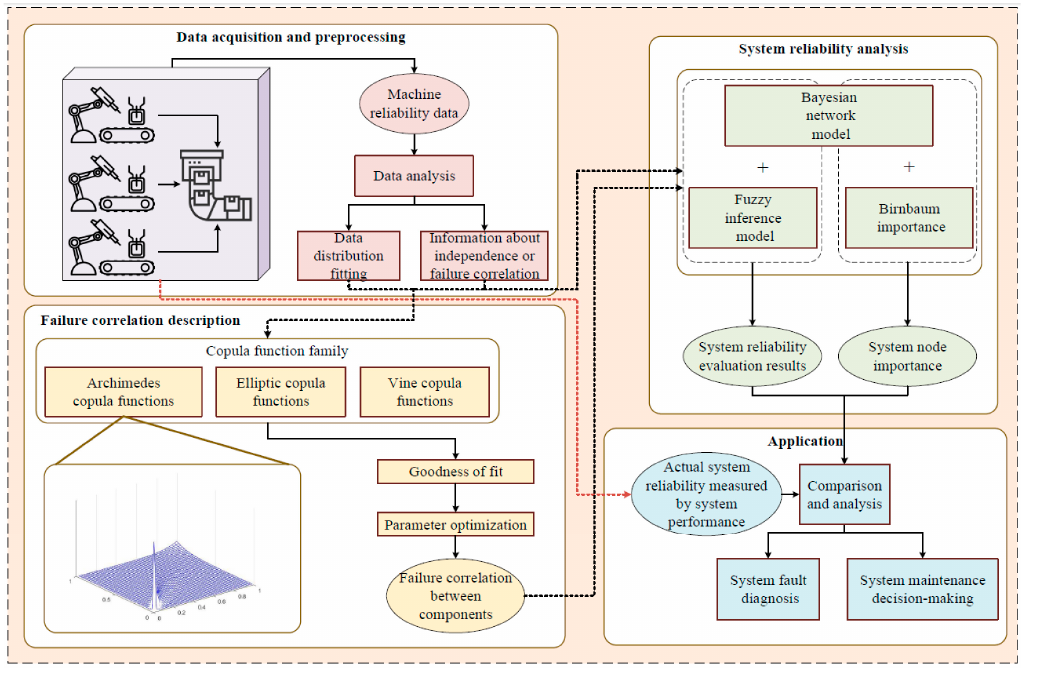
Figure 1. The proposed framework of system reliability analysis for failure-dependent manufactur- ing systems.